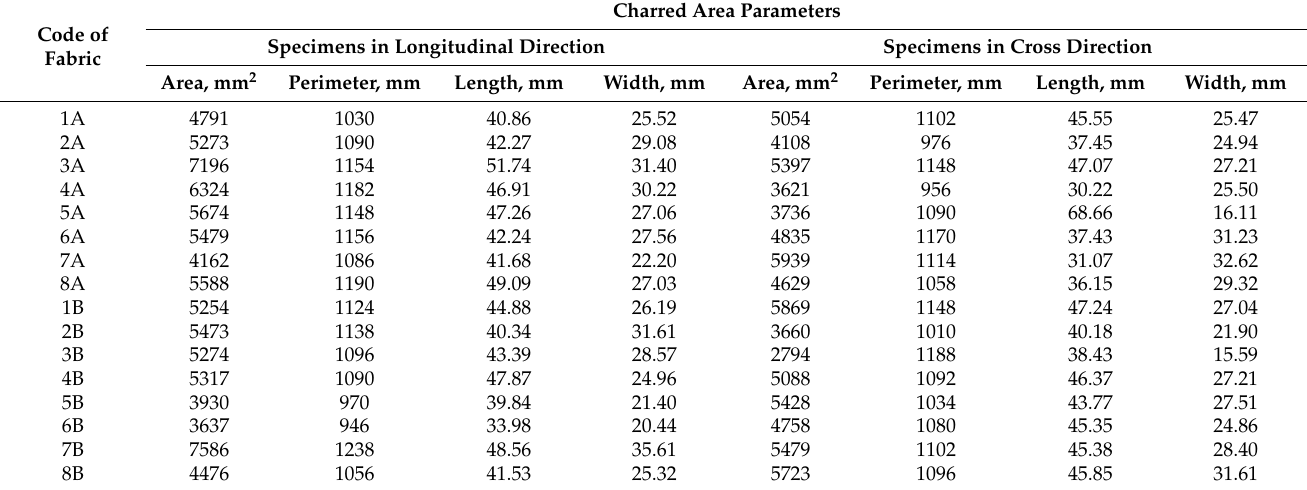
Table 8. Evaluation of charred area parameters after flame application to the fabrics.